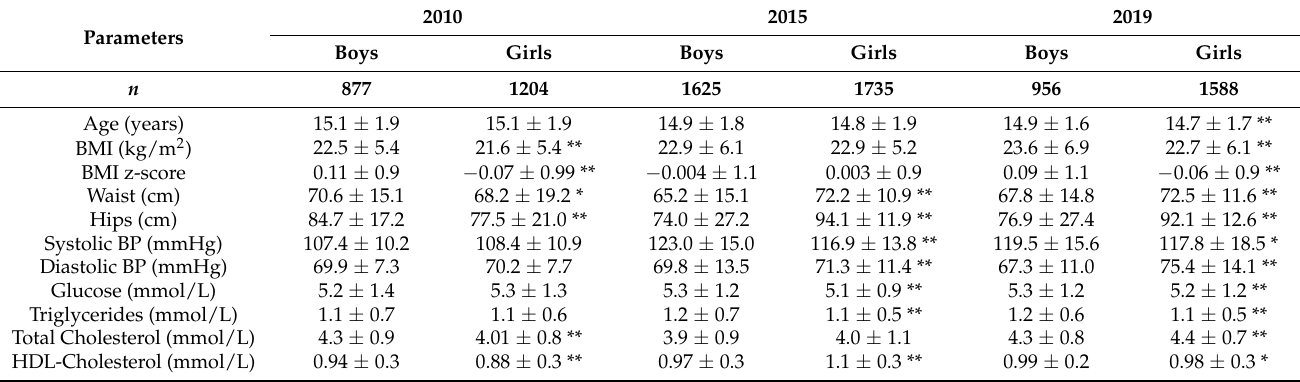
Table 1. Cardiometabolic characteristics of boys and girls in 2010, 2015, and 2019.